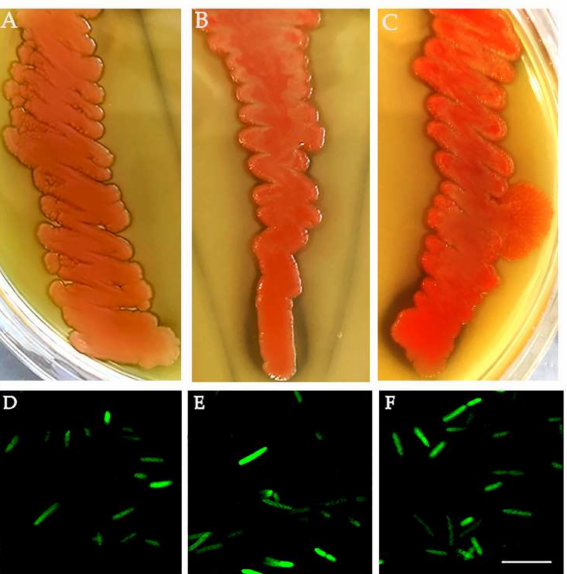
Figure 3. Asaia strains from C. capitata . Asaia isolates from the ( A ) Guatemala strain, ( B ) La r é union strain and ( C ) ISPRA strain. Asaia strains genetically modified to express a green fluorescent protein (GFP): ( D ) Guatemala strain, ( E ) La R é union strain and ( F ) ISPRA strain. Bar = 10 µ